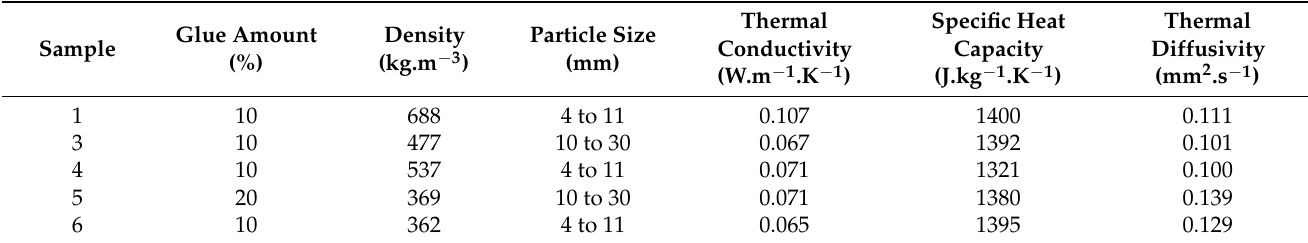
Table 2. Measured average values of input and output parameters for the boards with particles oriented parallel to the panel ´ s plane.